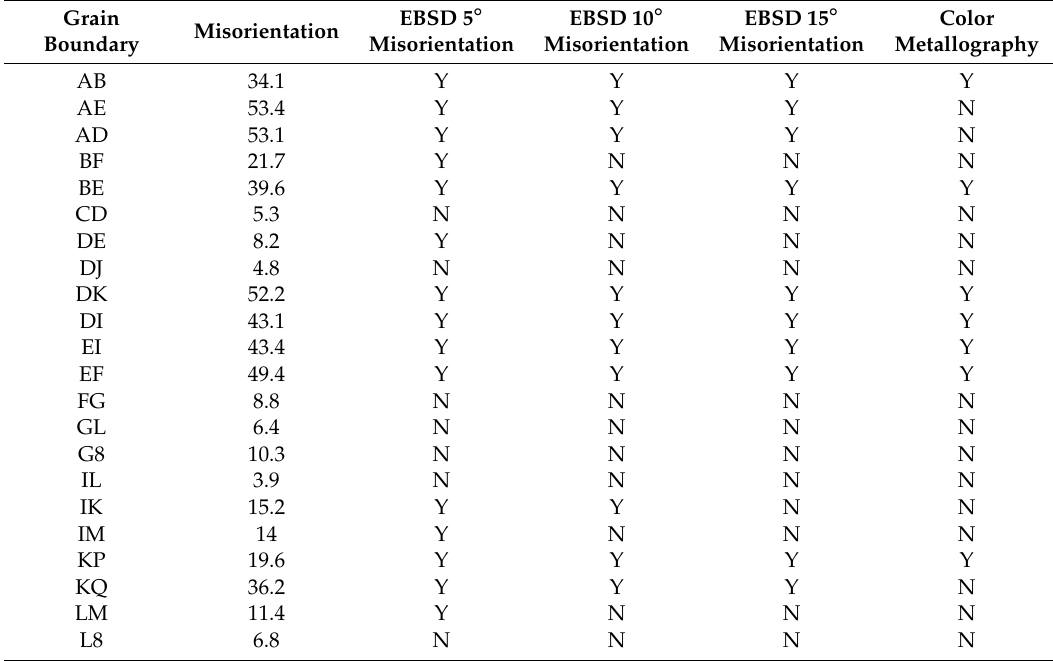
Table 5. EBSD data for as-cast magnetic stirring machine (EMS) billets, sand mold, poured at 690 ◦ C (Y, Yes; N, No).